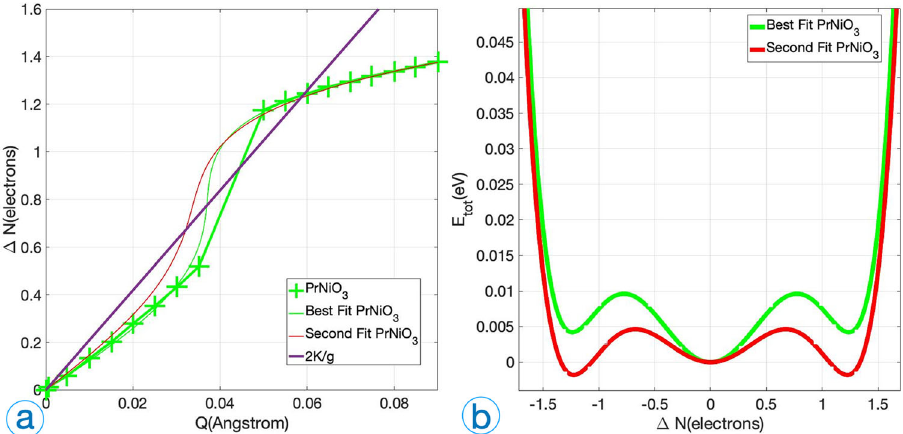
Fig. 4 Assessing the accuracy of the method by comparing multiple fi ts. Fits ( a ) and total energy ( b ) for PrNiO 3 based on Density Functional Theory + Dynamical Mean Field Theory data from ref. 6 ; green lines correspond to the optimal polynomial fi t, red lines to 4th and 6th kept constant to the values extracted for SmNiO 3 , and only the quadratic term fi tted to the data.